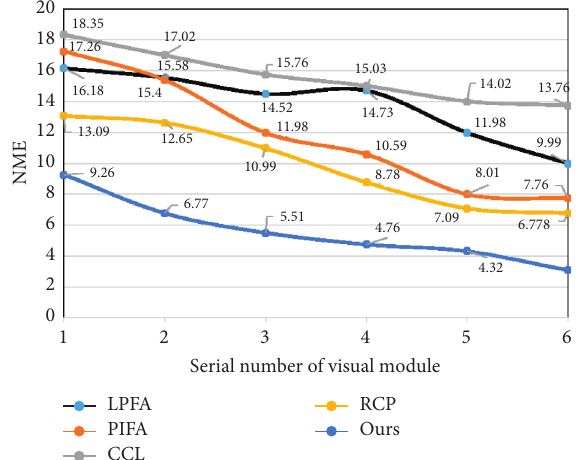
Figure 5: The error of each visualization block based on the LFW data set.